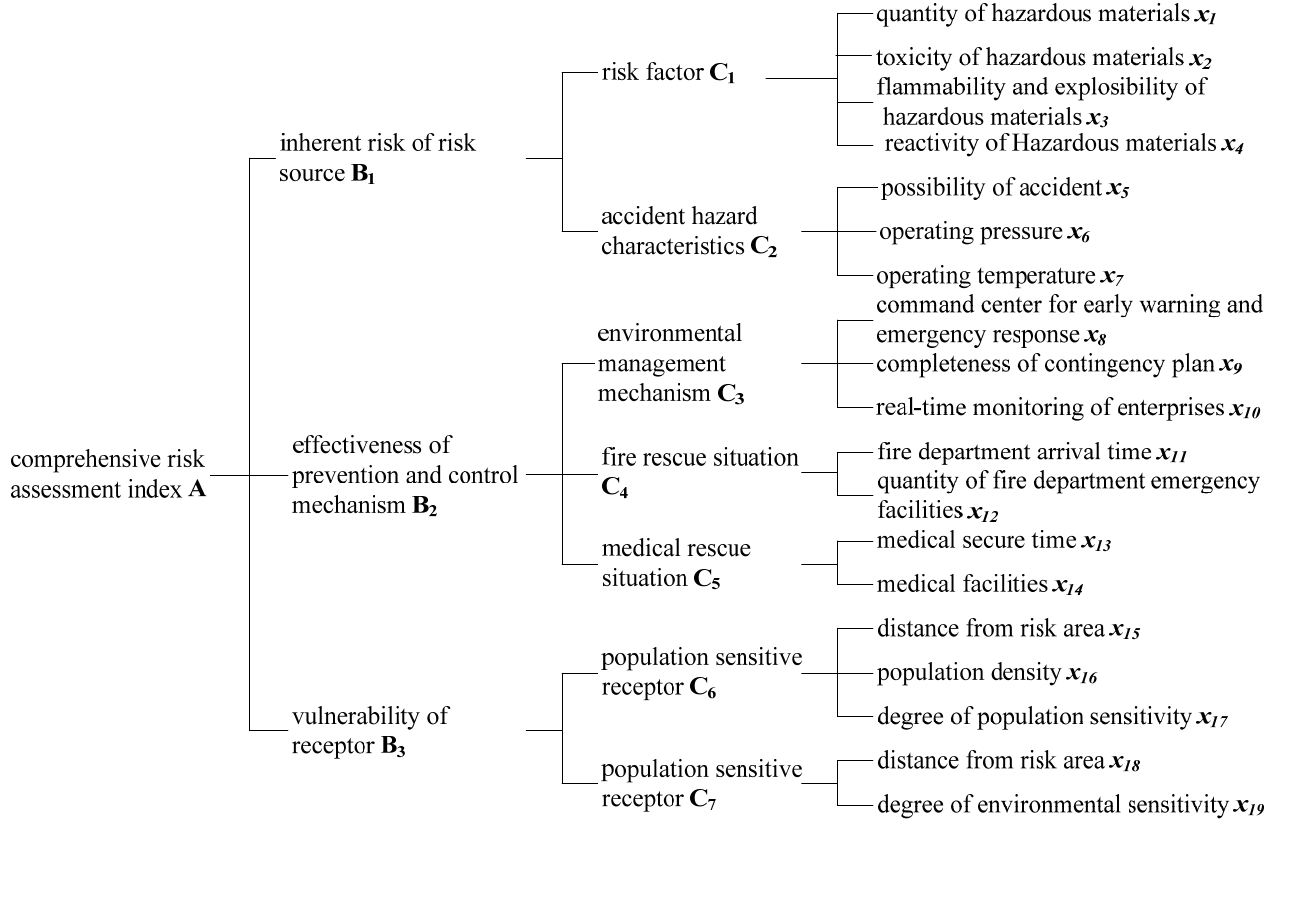
Figure 1. Comprehensive risk assessment index system for enterprises in chemical industrial